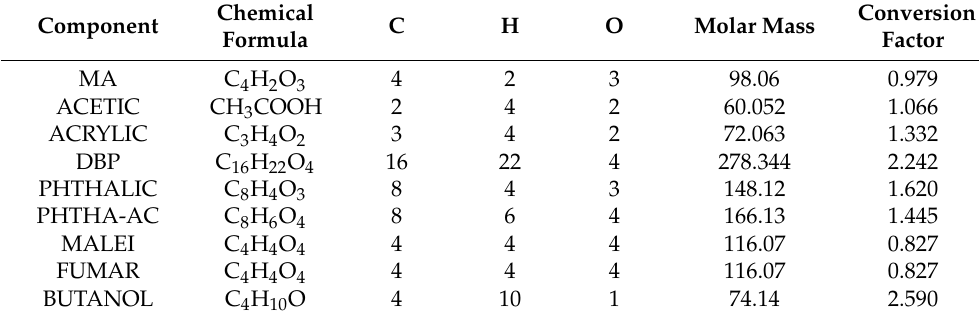
Table 7. COD Conversion